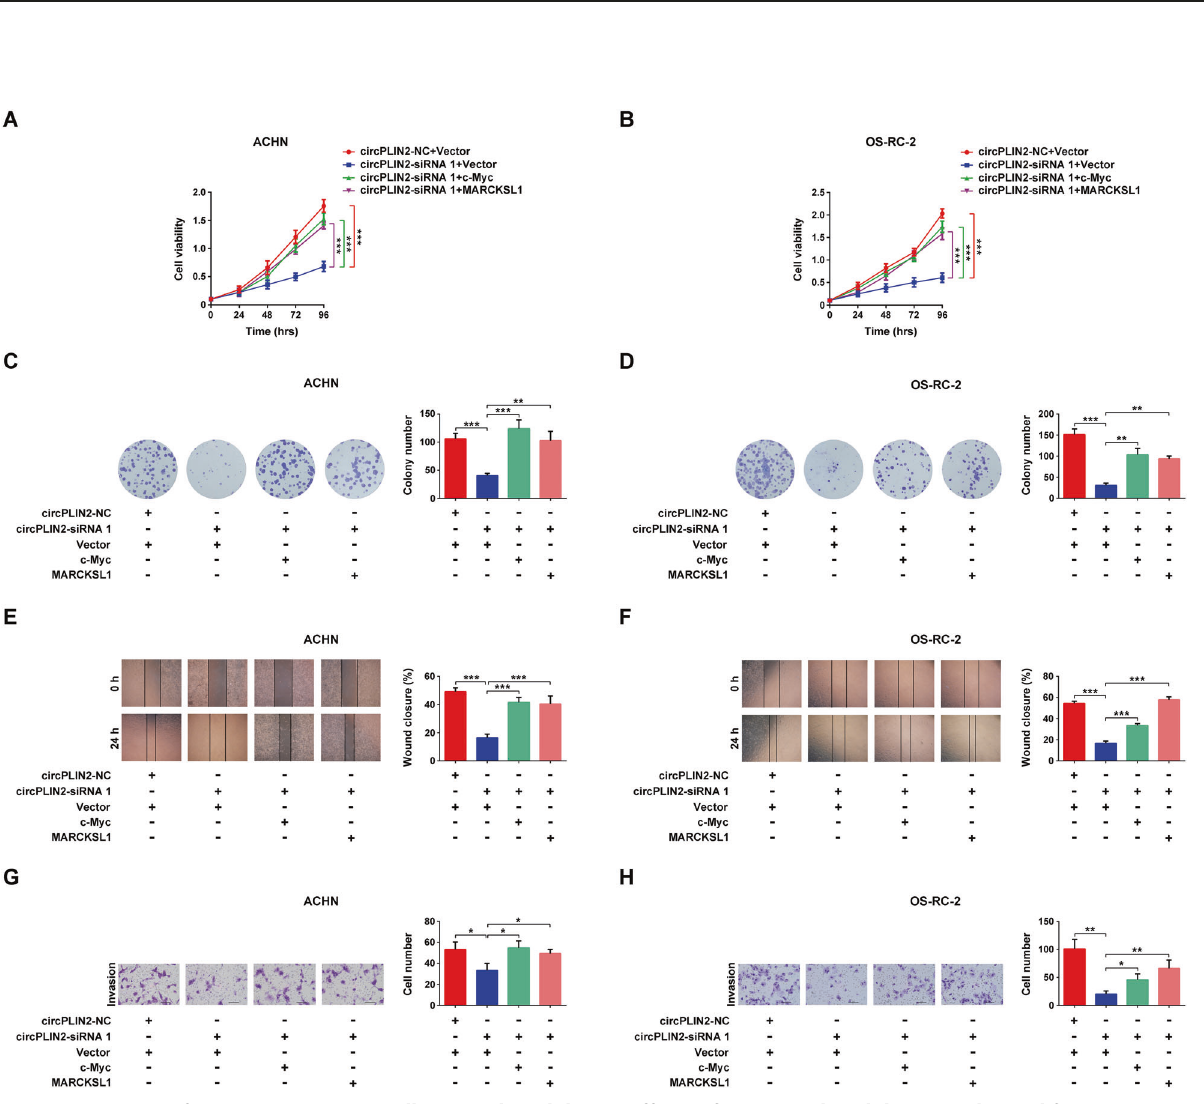
Fig. 4 circPLIN2 regulates the stability of the c-Myc and MARCKSL1 mRNAs by binding to the KH domains of IGF2BP proteins. A Schematic diagram of tagged RNA af fi nity puri fi cation assays for the detection of proteins bound to circPLIN2 in 293T cells. B The fl owchart delineates the steps of the LC – MS analysis for identifying proteins bound to circPLIN2 following tagged RNA af fi nity puri fi cation assays. LC – MS, liquid chromatography – mass spectrometry. C The chart for 12 proteins (unique peptides ≥ 2 both in LC – MS 1 and LC – MS 2) screened from LC – MS results. D Separation on SDS – PAGE gels and silver staining assays of the protein pulldown samples from 293T cells following tagged RNA af fi nity puri fi cation assays. E Western blot analysis of IGF2BP1, IGF2BP2, and IGF2BP3 protein levels in the protein pulldown samples from 293T cells following tagged RNA af fi nity puri fi cation assays. F RNA immunoprecipitation analysis of the fold enrichment of circPLIN2 with anti-IGF2BP1 antibody, anti-IGF2BP2 antibody or anti-IGF2BP3 antibody in 293T cells. The anti-IgG group was used as the control. G , H RT – qPCR analysis of the relative expression levels of FSCN1, TK1, c-Myc, and MARCKSL1 in ACHN ( G ) and OS-RC-2 ( H ) cells transfected with circPLIN2-siRNA 1/2 or circPLIN2-NC. I, J RT – qPCR analysis of the relative expression levels of FSCN1, TK1, c-Myc, and MARCKSL1 in ACHN ( I ) and OS-RC-2 ( J ) cells transfected with circPLIN2 or vector. K RT – qPCR analysis of the relative expression levels of c-Myc and MARCKSL1 in ACHN cells transfected with IGF2BPs or vector and circPLIN2-siRNA 1 or circPLIN2-NC. L RT – qPCR analysis of the relative expression levels of c-Myc and MARCKSL1 in ACHN cells transfected with si-IGF2BPs or si-NC and circPLIN2 or vector. M Schematic diagram of wild-type and truncated IGF2BP protein plasmids with GFP tags. WT, wild type. Del RRM1-2, deletion of the RRM1 and RRM2 domains in IGF2BP proteins. Del KH1-4, deletion of the KH1-4 domains in IGF2BP proteins. N – P RNA immunoprecipitation analysis of the fold enrichment of circPLIN2 with anti-GFP antibody or anti-IgG antibody in 293T cells transfected with IGF2BPs WT or IGF2BPs Del RRM1-2 or IGF2BPs Del KH1-